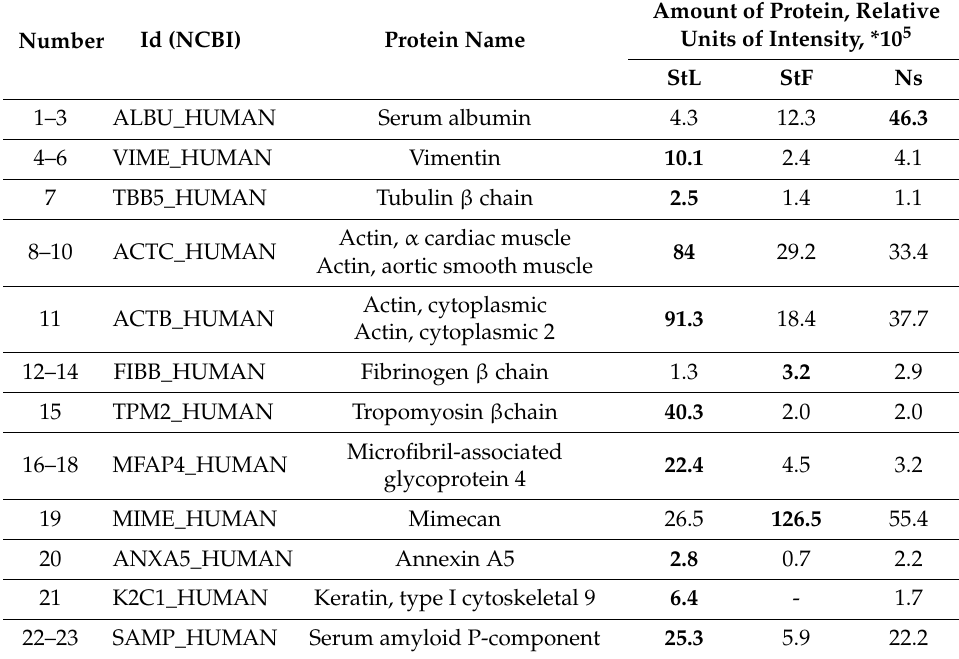
Table 2. Comparison of the amount of proteins in the pools of homogenates of atherosclerotic plaques (maximum in